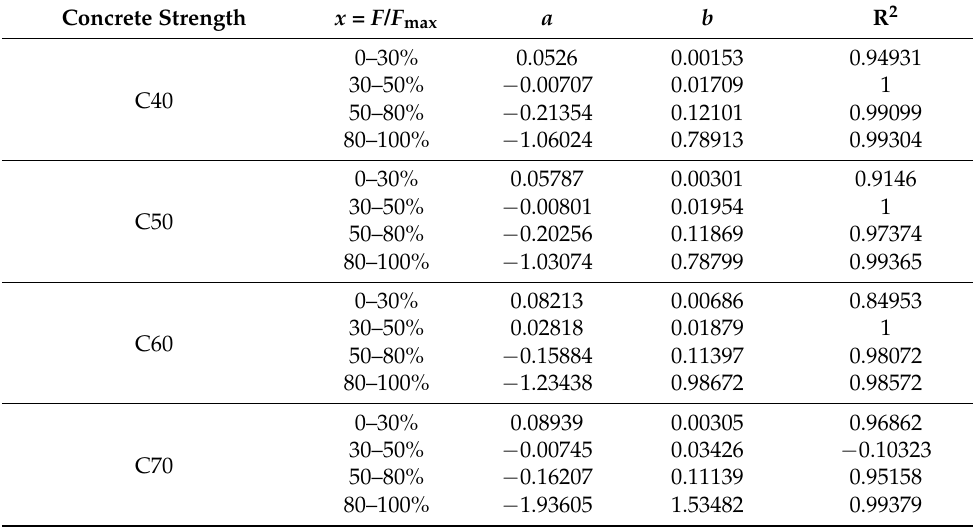
Table 3. Fitting curve parameters of concrete with different